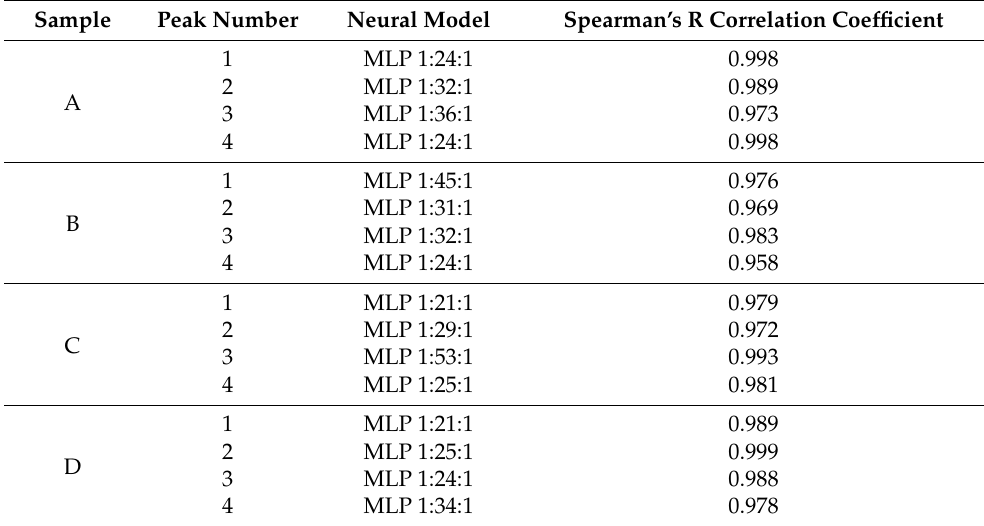
Figure 2. Comparison of experimental α (T) functions and those calculated from the kinetic model for stage I of protein denaturation. Table 3. Quality of neural models with Spearman’s rank correlation coefficients between neurons.